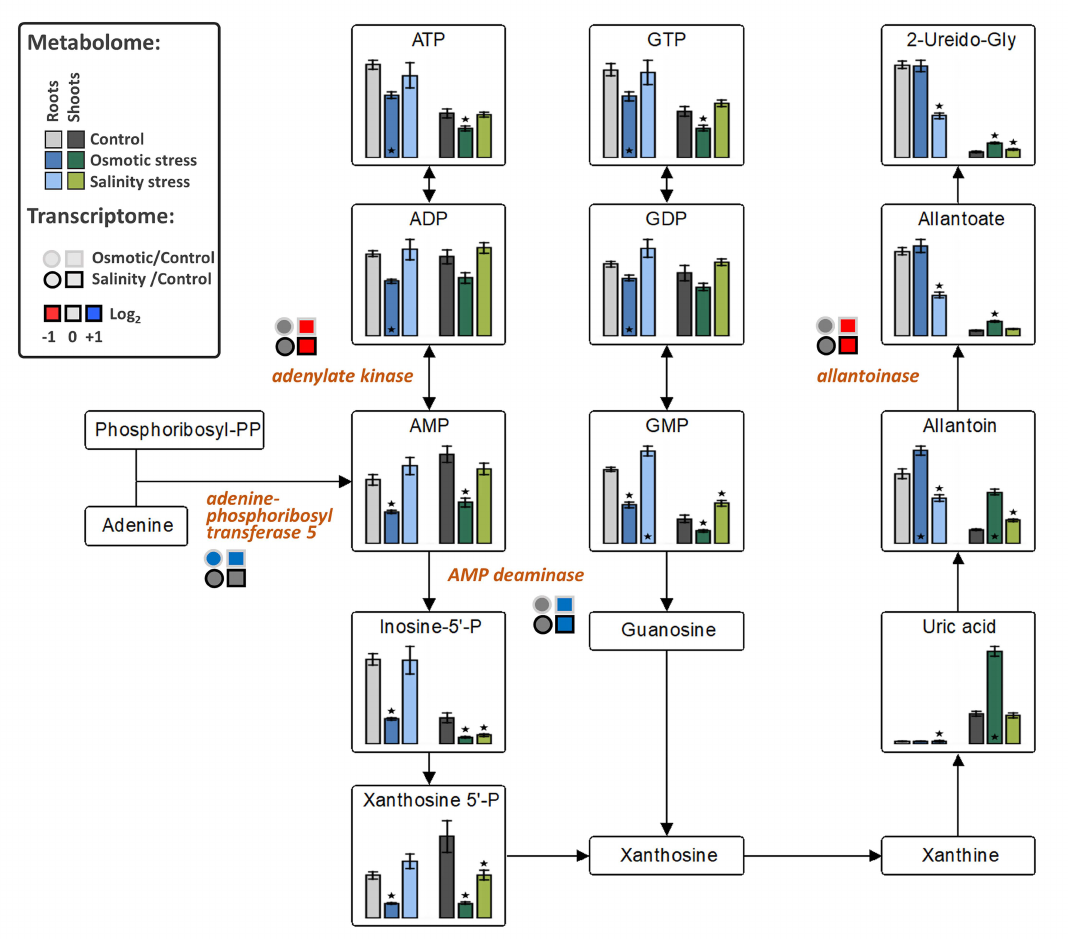
Figure 6. The e ff ect of osmotic and salinity stresses on the purine catabolism and corresponding transcriptomic changes in roots and shoots of Hordeum marinum. Metabolic data, presented as bars, are means ± SE; n = 7. Significant di ff erences to control treatments at specified time points after excision are indicated by *, p < 0.05 (Wilcoxon, Mann-Whitney U-test). Up-regulated genes are labeled by blue, down-regulated by red color, and those with no changes in expression by grey